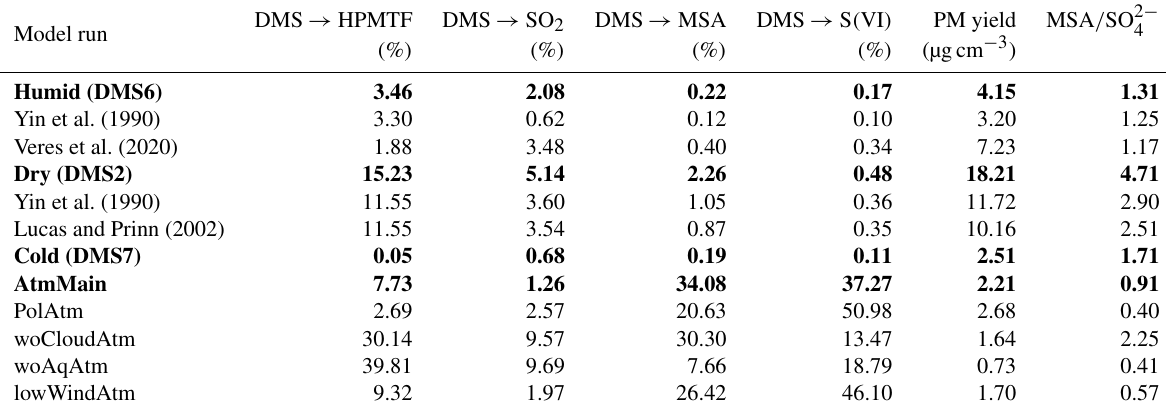
Table 4. Summary of modelled DMS conversion yields to HPMTF, SO 2 , MSA and S ( IV ) , total PM yields and MSA / SO 2 − humid, dry and cold chamber plus atmospheric relevant conditions. Rows in bold denote base runs, while rows in roman denote sensitivity